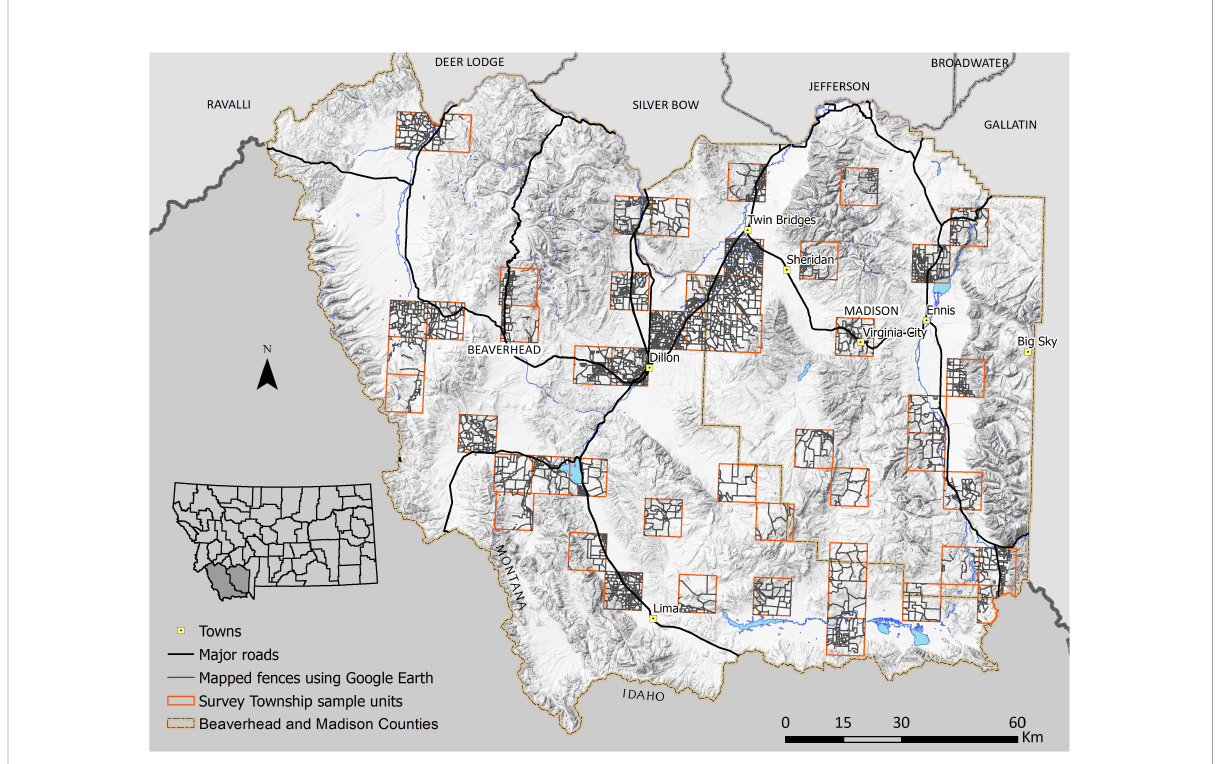
FIGURE 3 Fences manually digitized in Google Earth Pro within a random sample (n = 50) of Survey Townships each approximately 93 km 2 in Beaverhead and Madison Counties, Montana. Mapping fences using Google Earth Pro was highly accurate (K = 0.76) in open land cover types but was impossible in forested